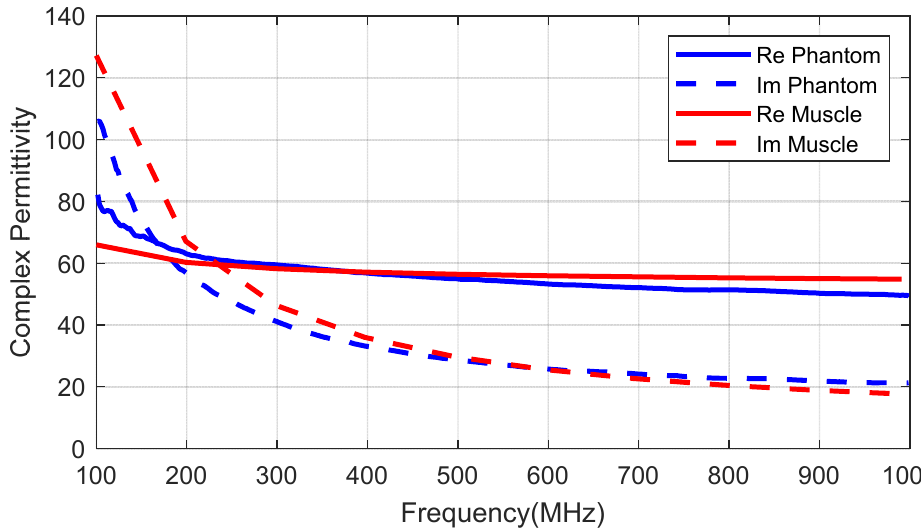
Figure 7. Measured dielectric permittivity (real and imaginary part) as a function of frequency and comparisons with muscle tissue data.